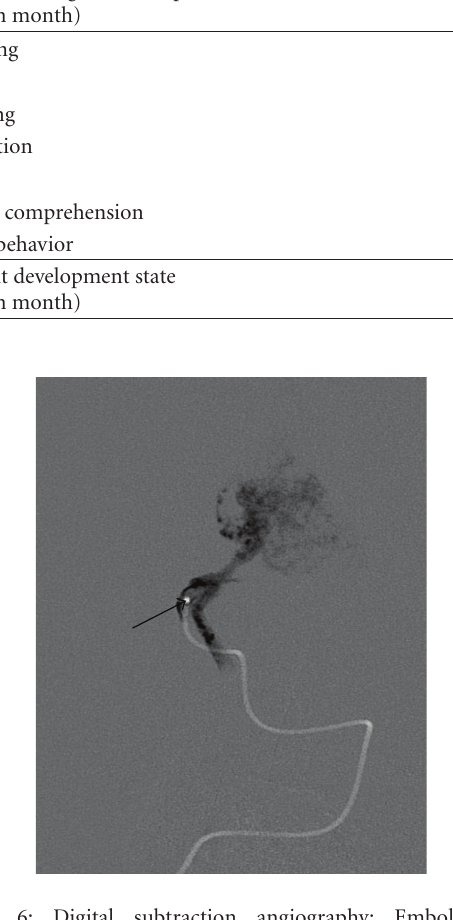
Figure 6: Digital subtraction angiography: Embolisat-Cast (NBCA), (arrow: catheter tip).